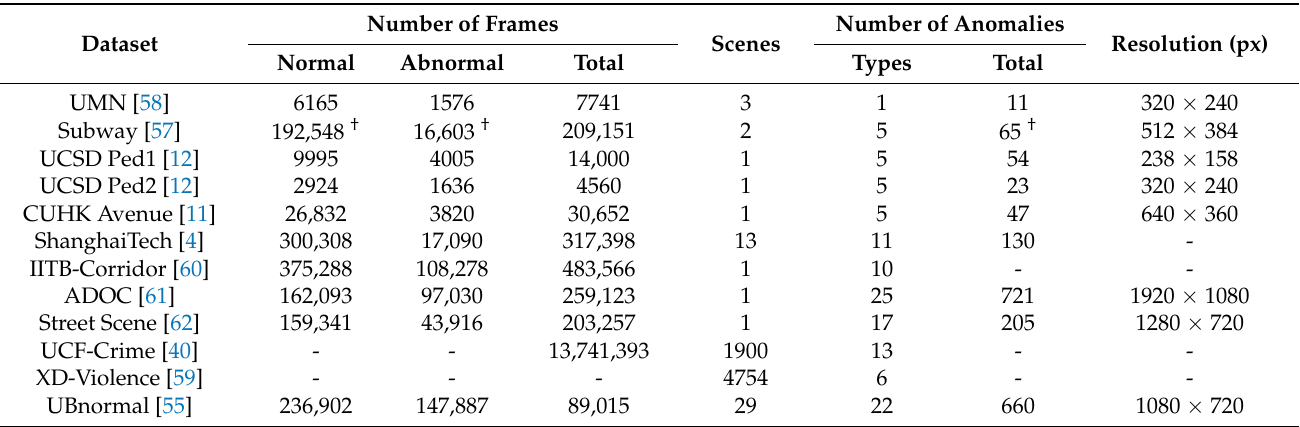
Table 5. Brief summary of relevant information regarding the analysed anomaly detection